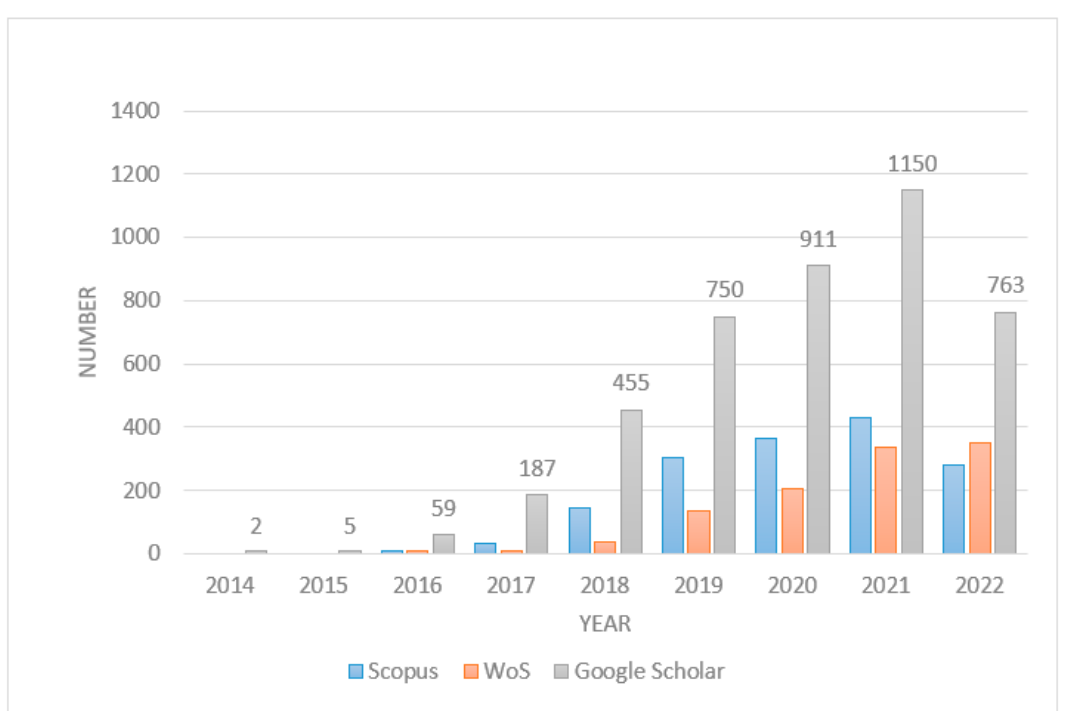
Figure 2. Growth of research articles.